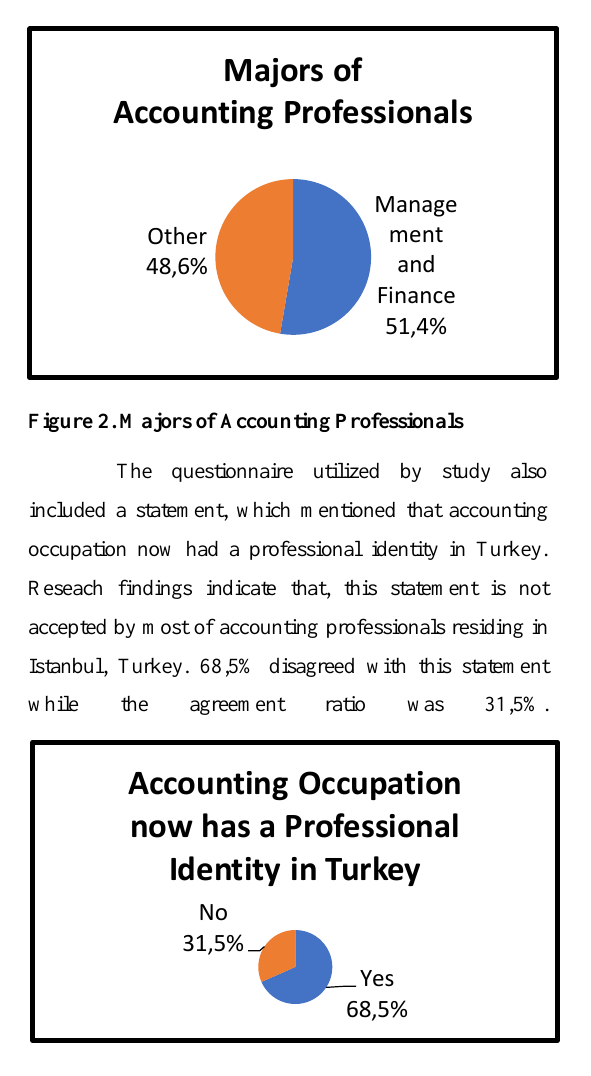
Figure 3. Accounting Occupation now has a Professional Identity in Turkey